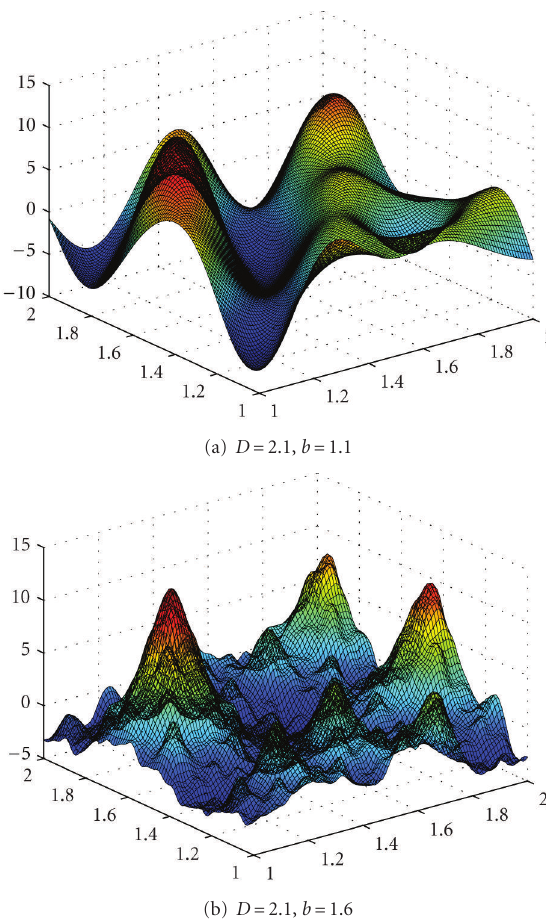
Figure 1: Two W-M surfaces produced using di ff erent rough surface densities.